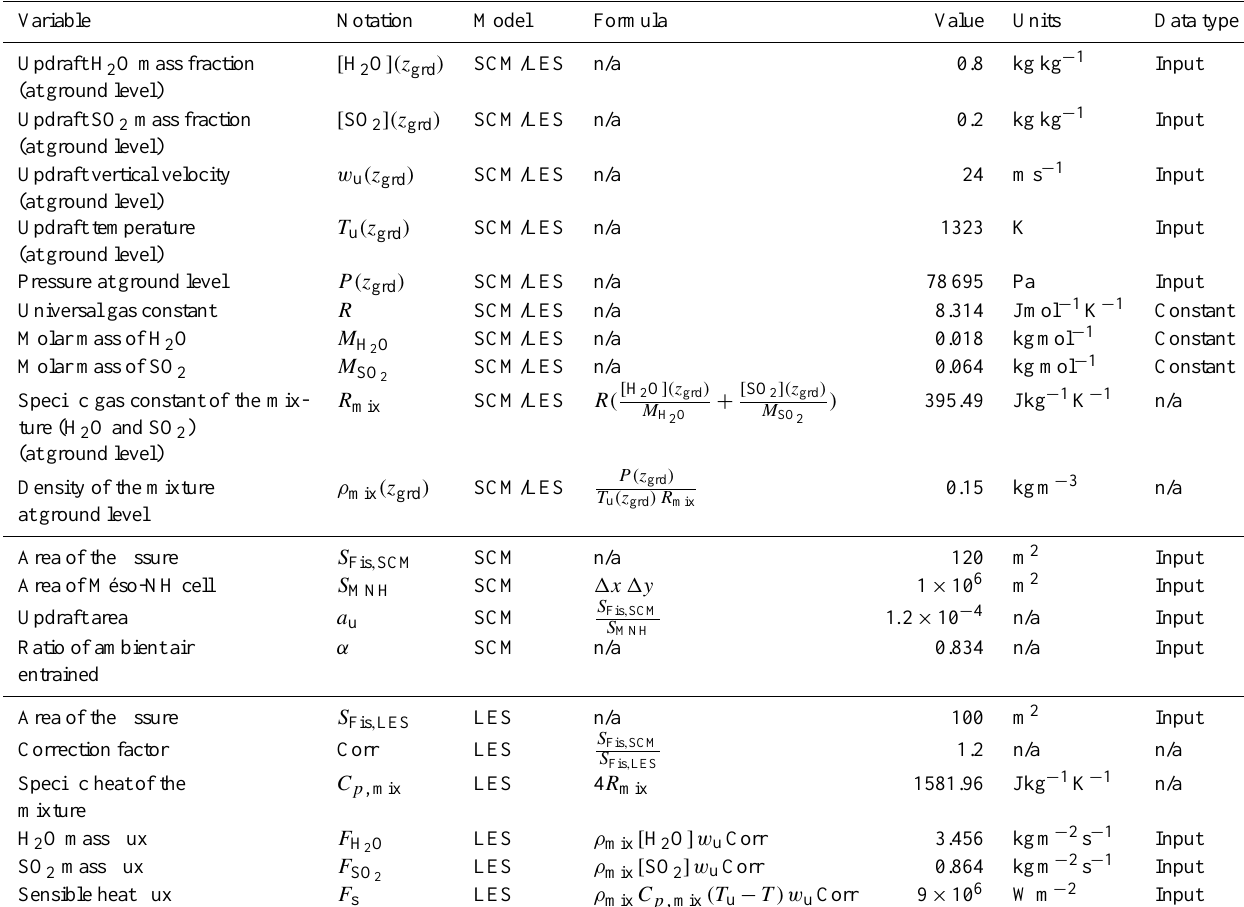
Table 1. Variables and values used for LES and SCM models.